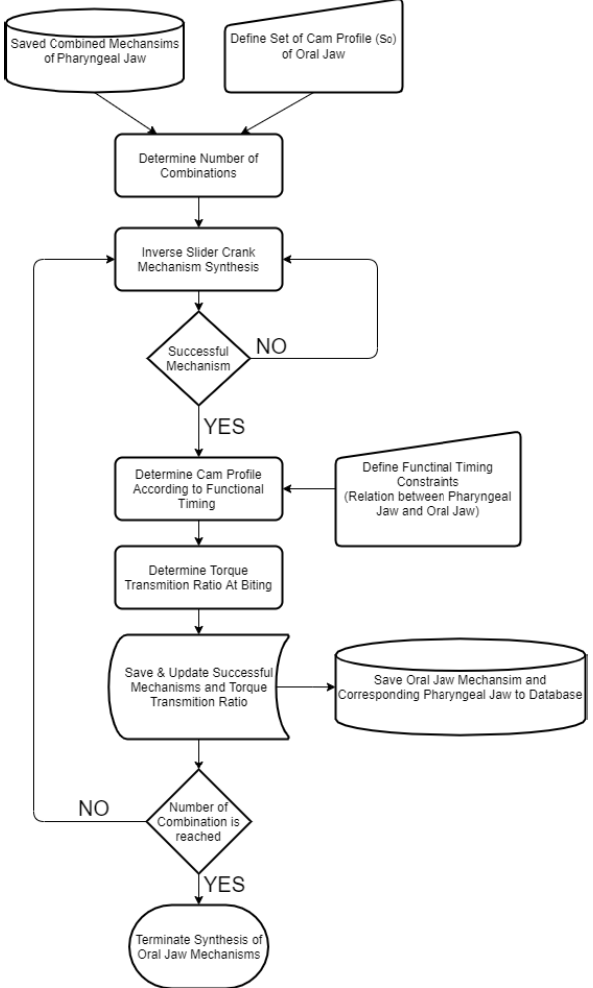
Figure 15. Algorithm for designing the inverse slider – crank mechanism at the oral